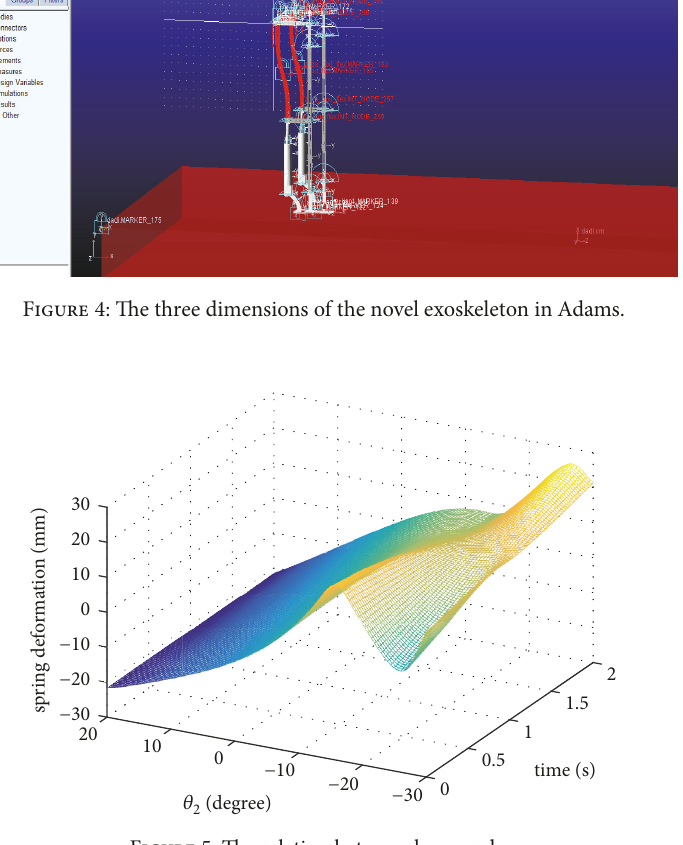
Figure 5: The relation between knee and 𝛼 .